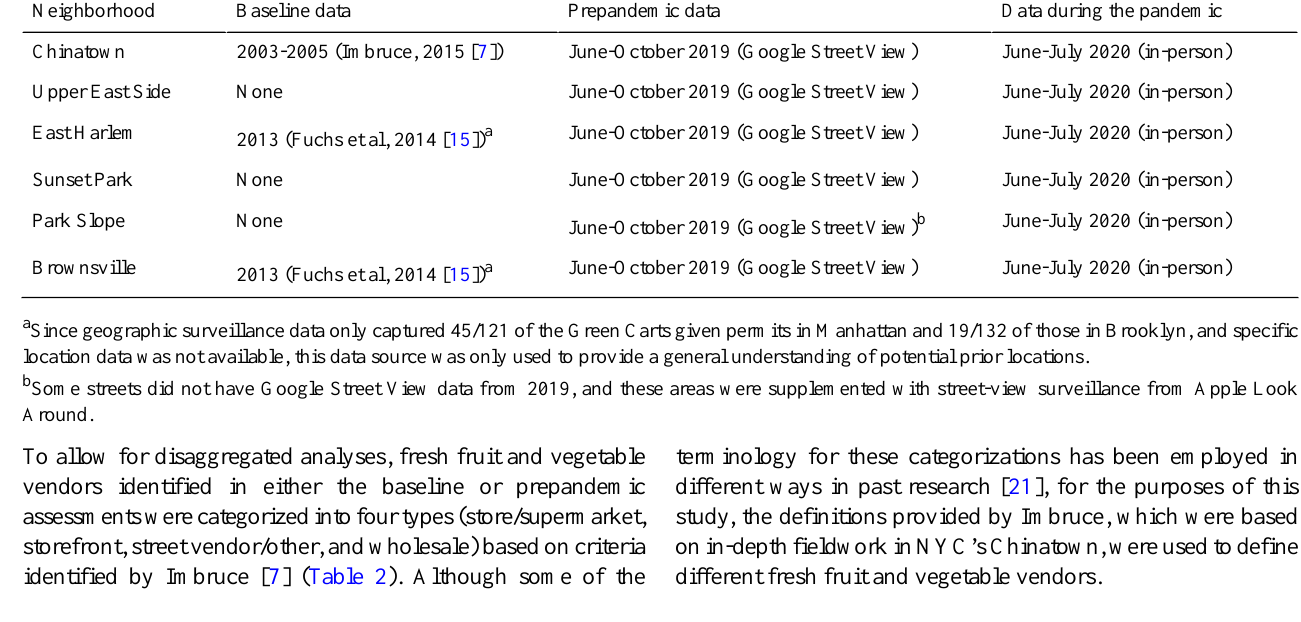
Data during the pandemicPrepandemic dataBaseline dataNeighborhood